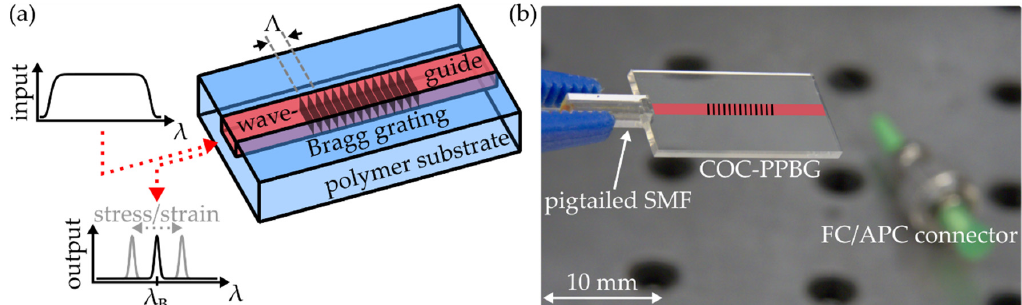
Figure 1. ( a ) Working principle of a polymer planar Bragg grating sensor; ( b ) Polymer planar Bragg grating in a cyclic olefin copolymer substrate (COC-PPBG); positioning of waveguide and Bragg grating are indicated), butt-coupled to a pigtailed standard single-mode fiber.